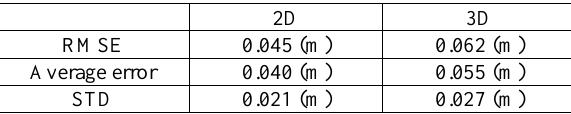
Table 6. The results of modelling roads in OpenDRIVE